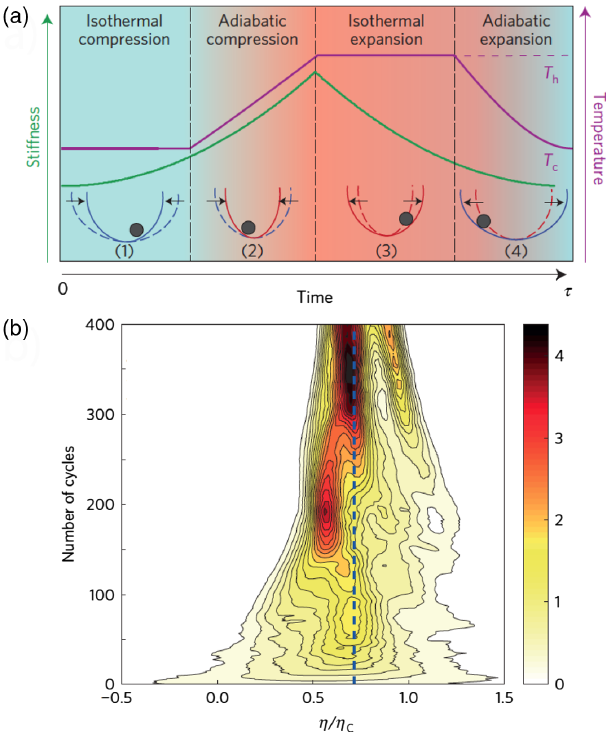
FIG. 13. (a) Schematic of the Carnot cycle applied to a Brownian particle trapped in a harmonic potential by a laser beam. The bottom row indicates the harmonic potential as a function of time. The stiffness of the potential is controlled by the laser intensity, as indicated by the green line. A random force, applied to the particle, plays the role of an effective temperature whose value is changed as indicated by the magenta line. (b) Contour lines of the probability distribution of the cycle efficiency averaged on n number of cycles. The efficiency η is normalized to the Carnot efficiency η . The black dashed line c indicates the mean value of η = η (adapted from Ref. c